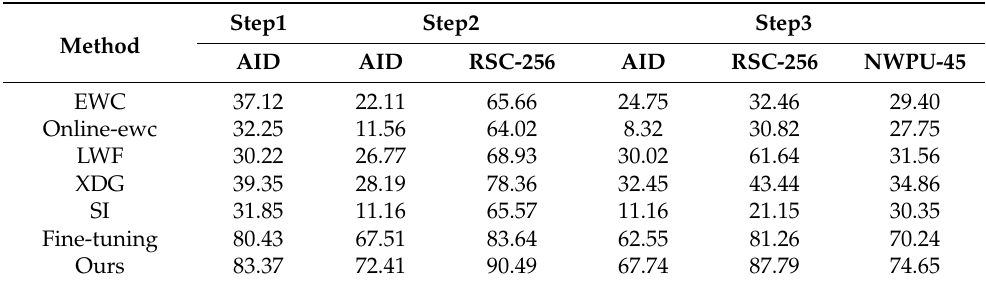
Table 3. Overall accuracy of comparison methods on three-step continual scene classification tasks.